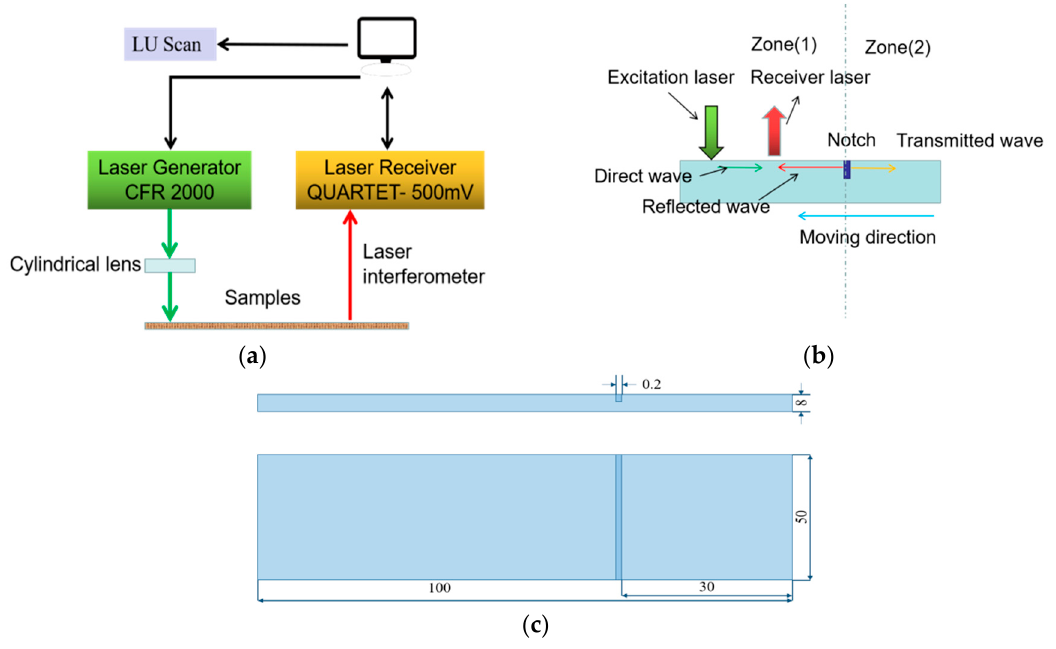
Figure 11. ( a ) Ultrasonic laser detection system. ( b ) Scanning path. ( c ) Sample size (unit: mm).